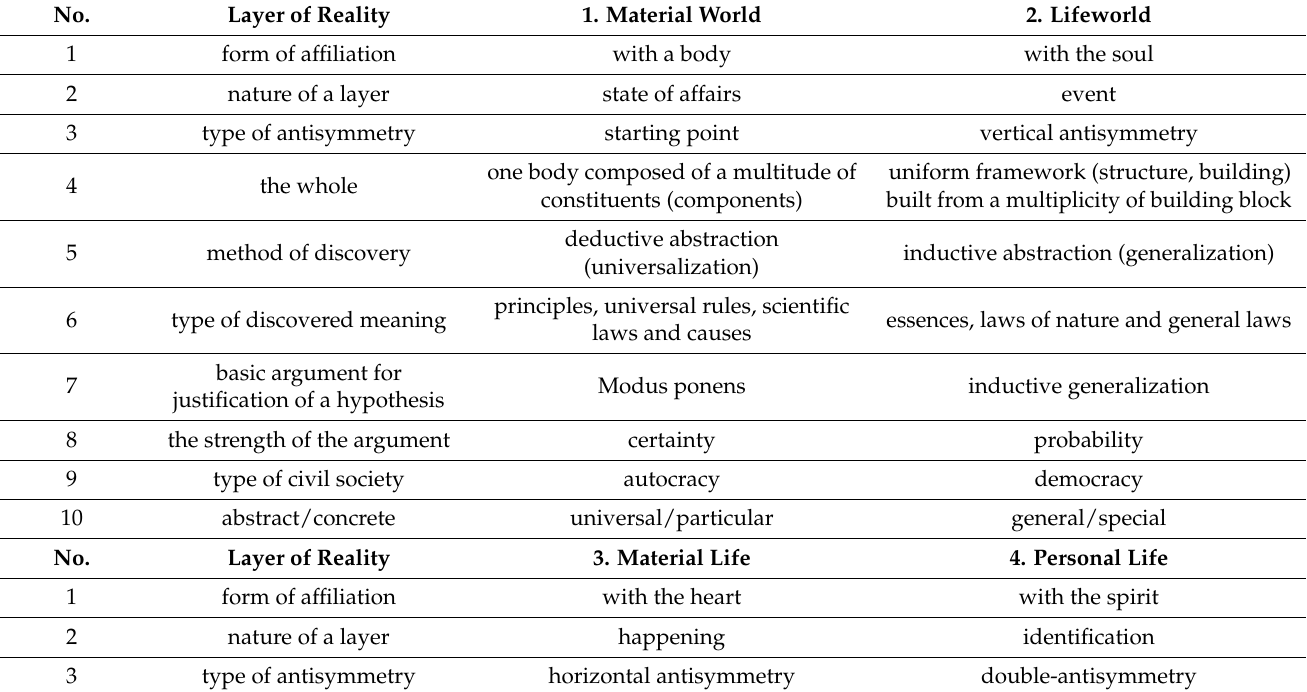
Table 1. Four different layers of reality and its key